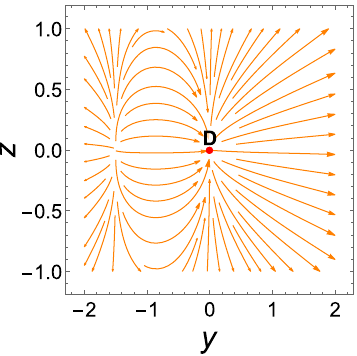
Fig. 10 Two dimensional flow for (B.82), (B.83). The physical region of the phase space is y := 1